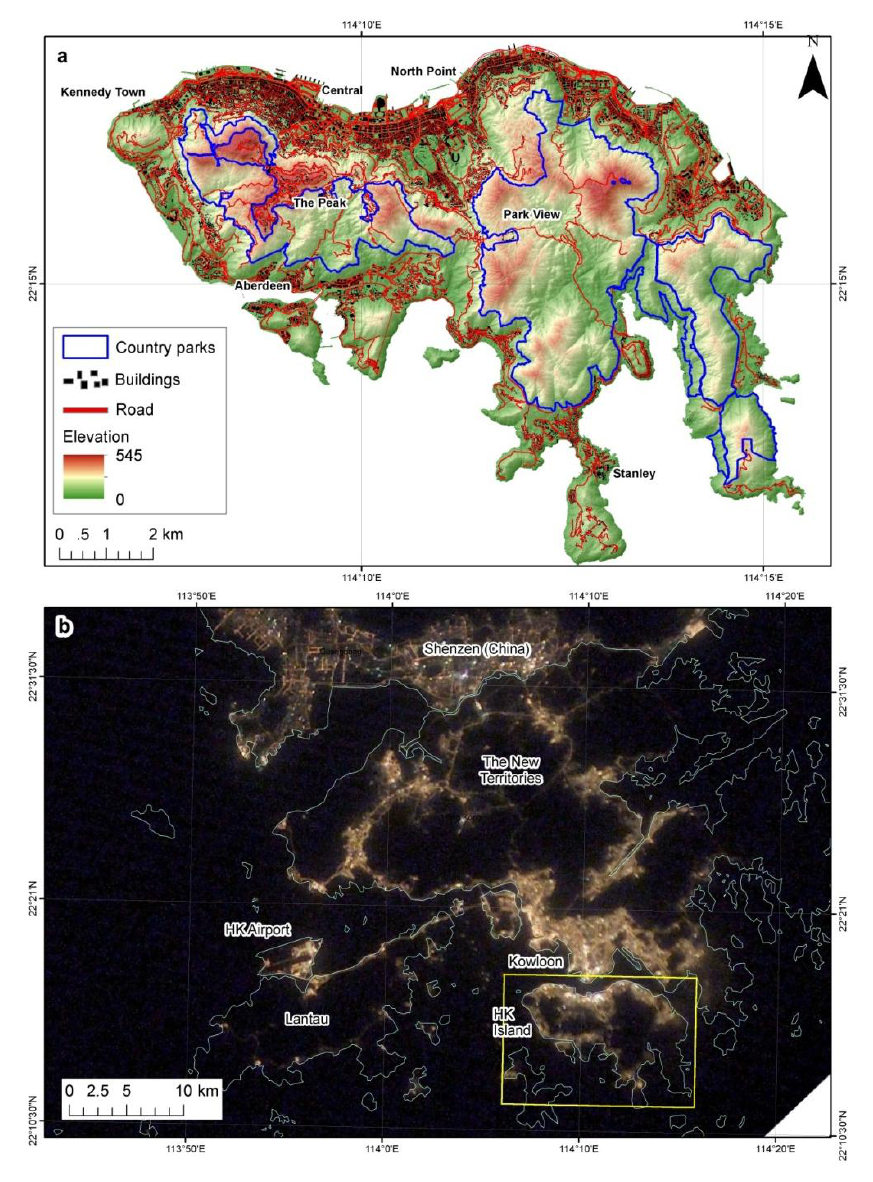
Figure 1. Hong Kong Island study area ( a ). The bottom image ( b ) shows night-lights (an indicator for human activity) over the entire Special Administrative Region of Hong Kong as photographed from the International Space Station on 10 March